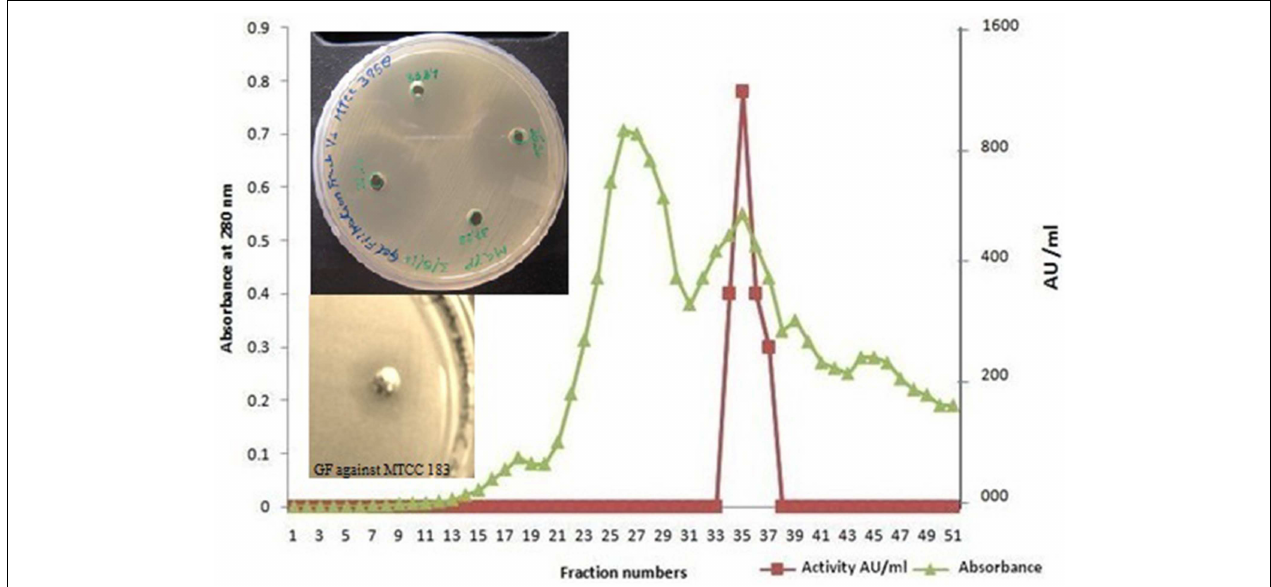
FIGURE 2 | Gel filtration elution profile of ACP on Sephadex G 75 column. Anti- Candida activity was detected in fractions 31–36. The pooled fractions showed a distinct anti- Candida activity against C. albicans MTCC 3958 and MTCC 183 in the inset. (cid:4) , represents AU ml − 1 ; N , represents absorbance at 280nm.